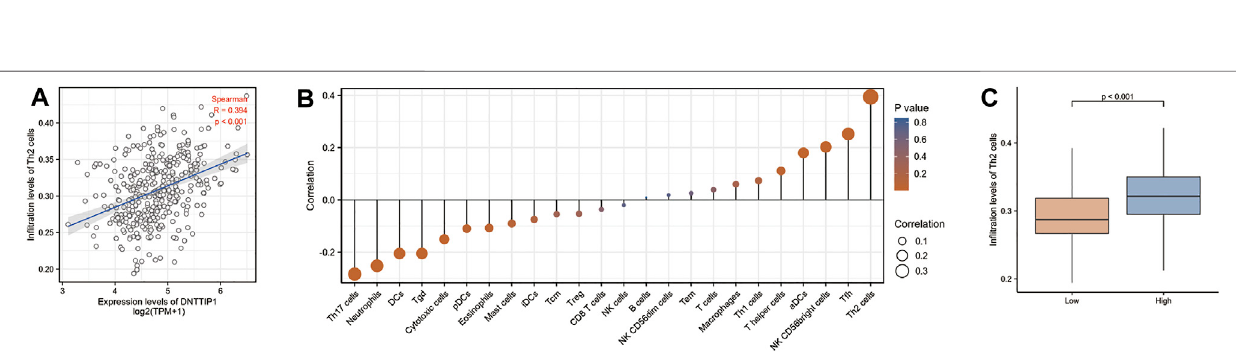
FIGURE3| ResultsofanalysisbetweenDNTTIP1expressionandimmunein fi ltration. (A) Th2cellsweresigni fi cantlypositivelycorrelatedwithDNTTIP1expression. (B) Correlation between the relative abundances of 24 immune cells and DNTTIP1 expression level. The color of dots shows the absolute value of Spearman R. (C) Th2 cell in fi ltration level in different DNTTIP1 expression